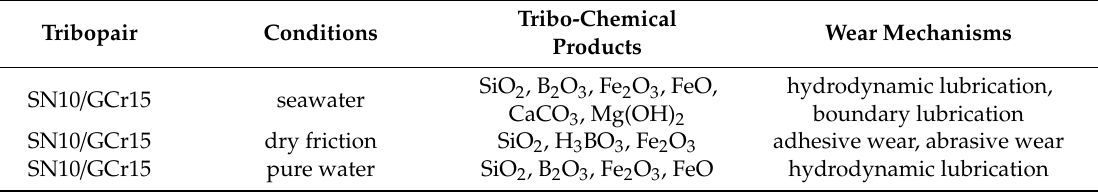
Table 5. Tribo-chemical products and wear mechanisms of the SN10 / GCr15 tribopair under di ff erent lubrication